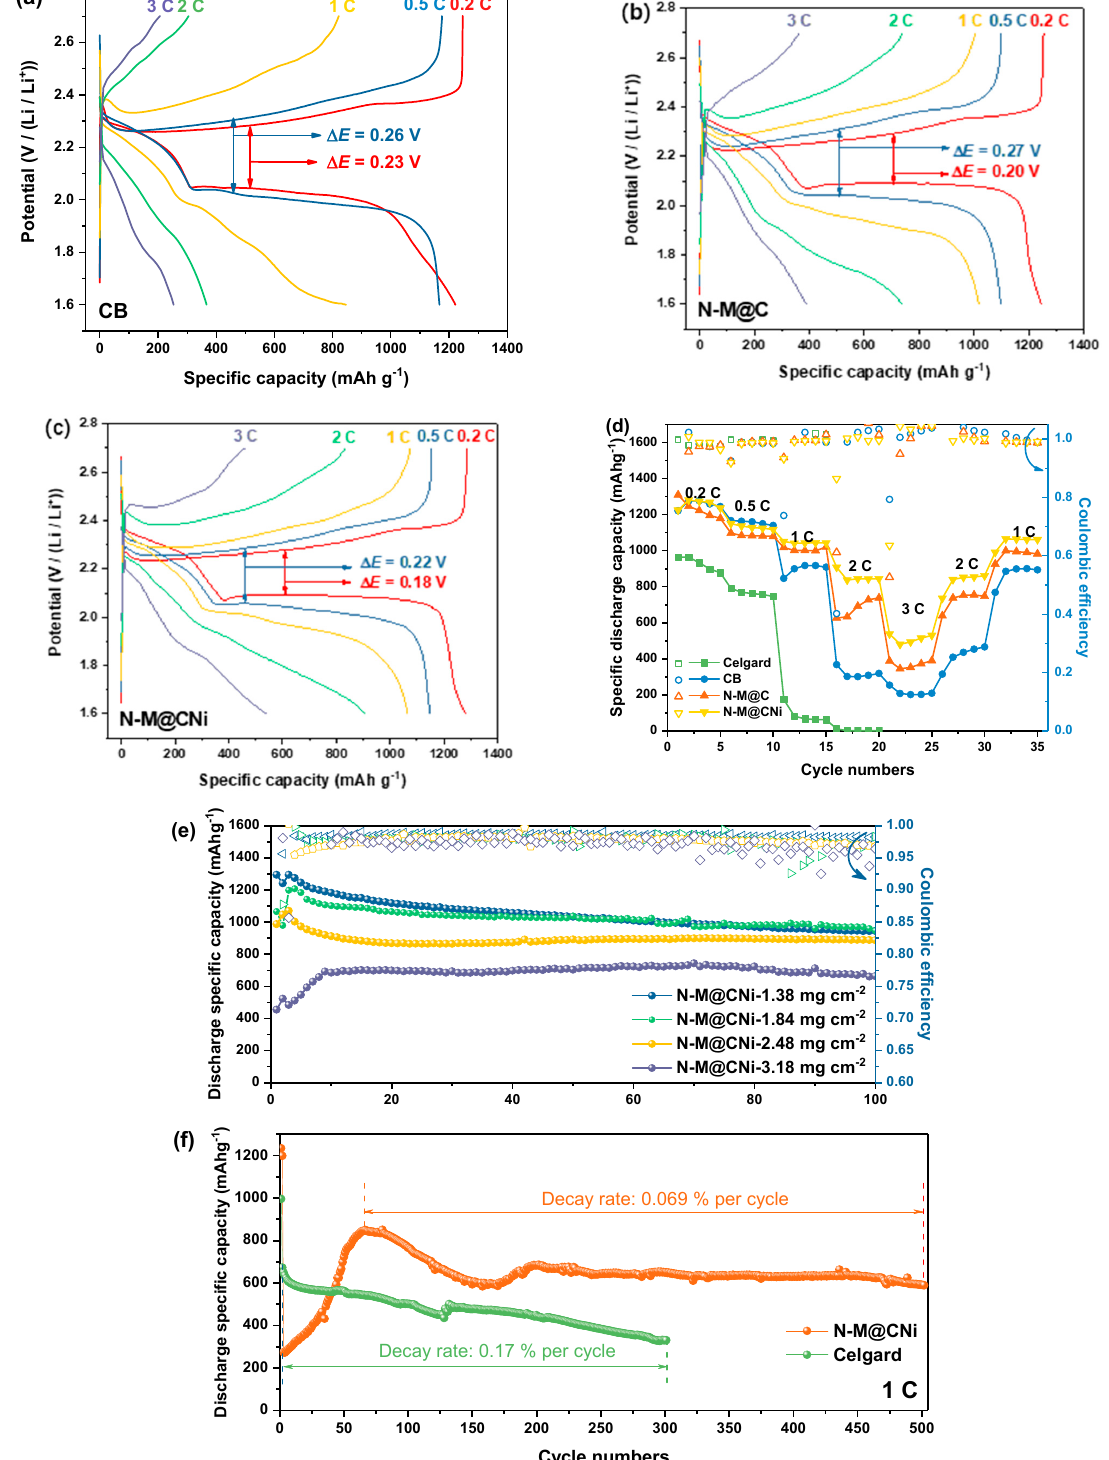
Figure 6. The typical galvanostatic charge and discharge (GCD) curves of ( a ) CB, ( b ) N-M@C, and ( c ) N-M@CNi cells at 0.2 C, 0.5 C, 1 C, 2 C, and 3 C. The rate performance ( d ) of the Celgard, the CB, the N-M@C and the N-M@CNi cells at a current of 0.2 C. ( e ) The cycling performance comparison of N-M@CNi cells with different sulfur mass loading cathodes at 0.2 C. ( f ) The long-term cycling performance of Celgard and N-M@CNi cells at 1